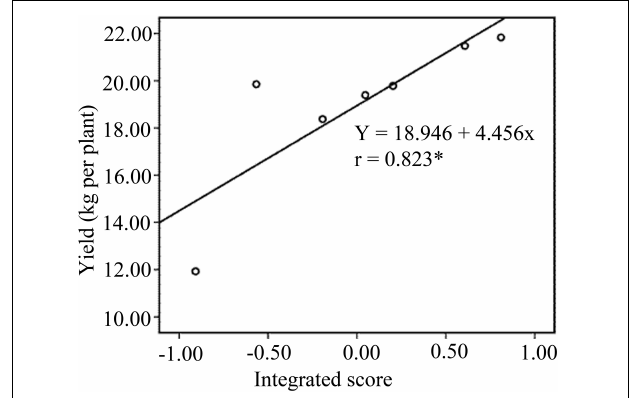
FIGURE 1 | Linear regression relationship between integrated score and banana yields of